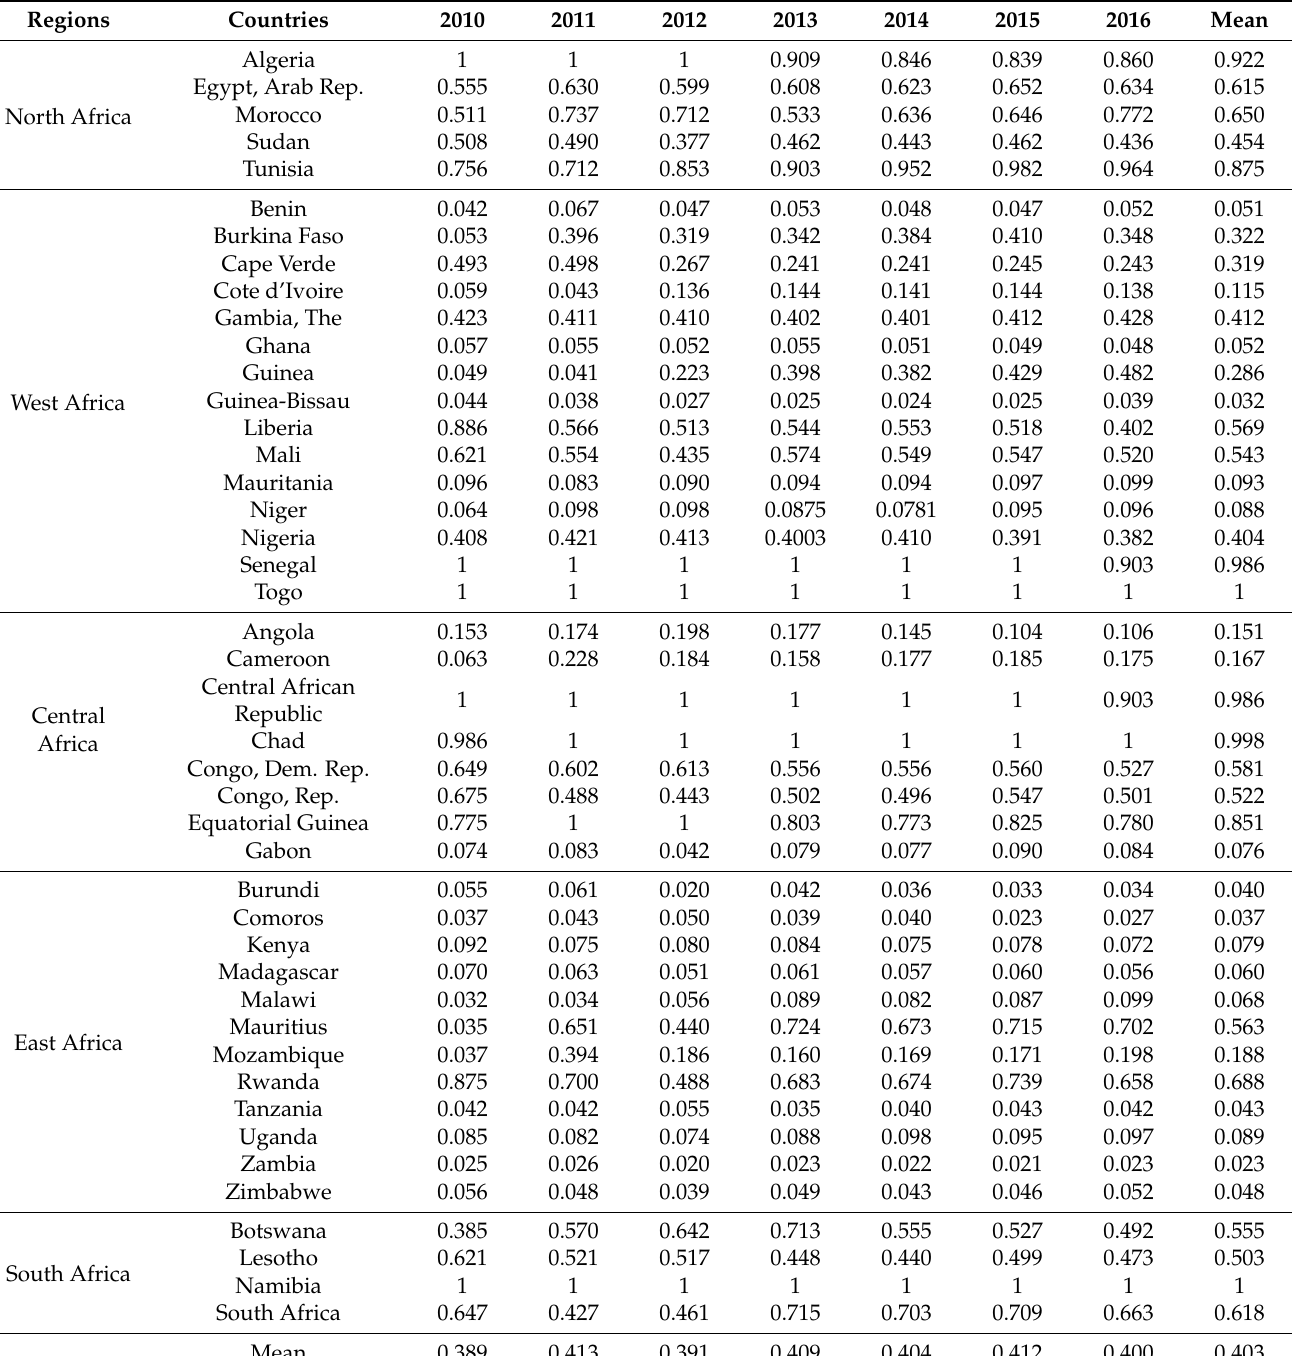
Table 5. Africa’s MDSTFEE overall efficiencies from 2010 to